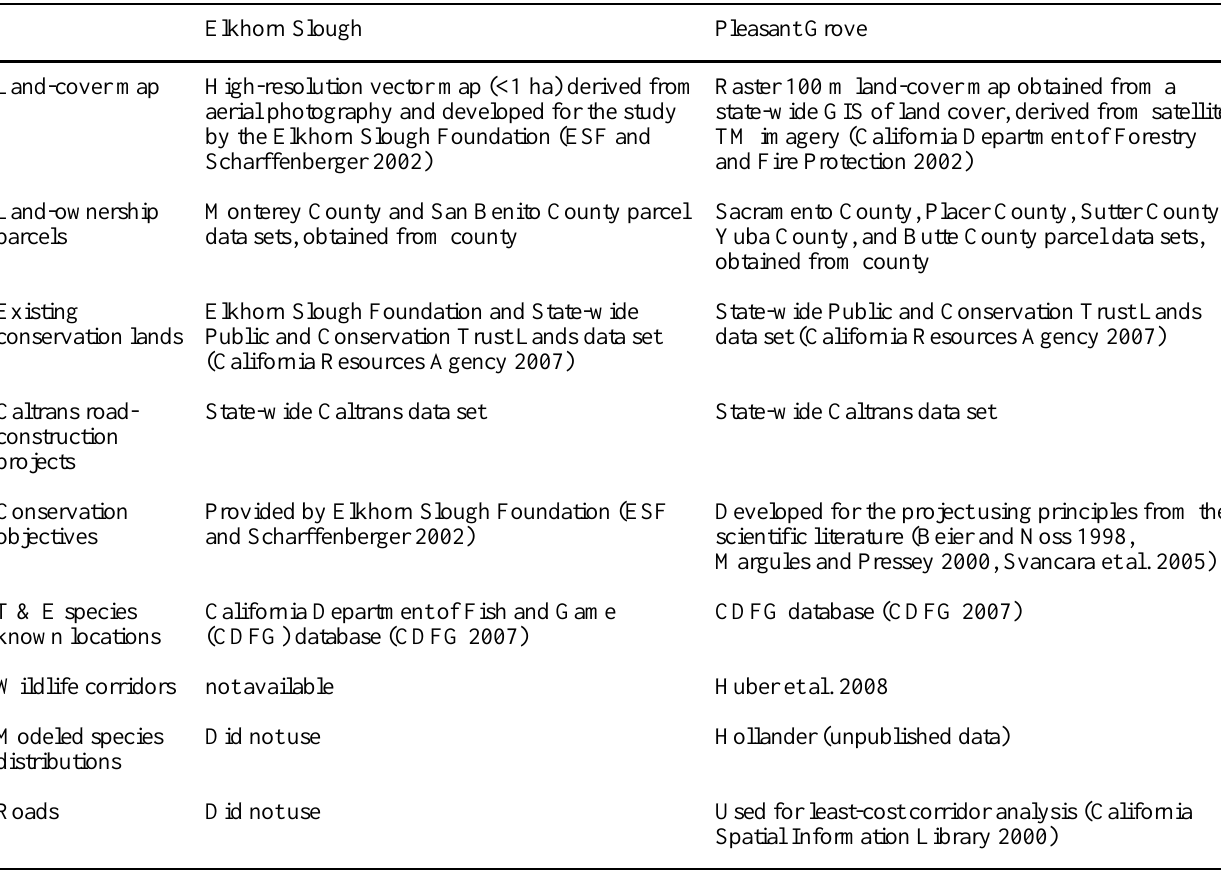
Table 1. Data differences between Elkhorn Slough and Pleasant Grove study